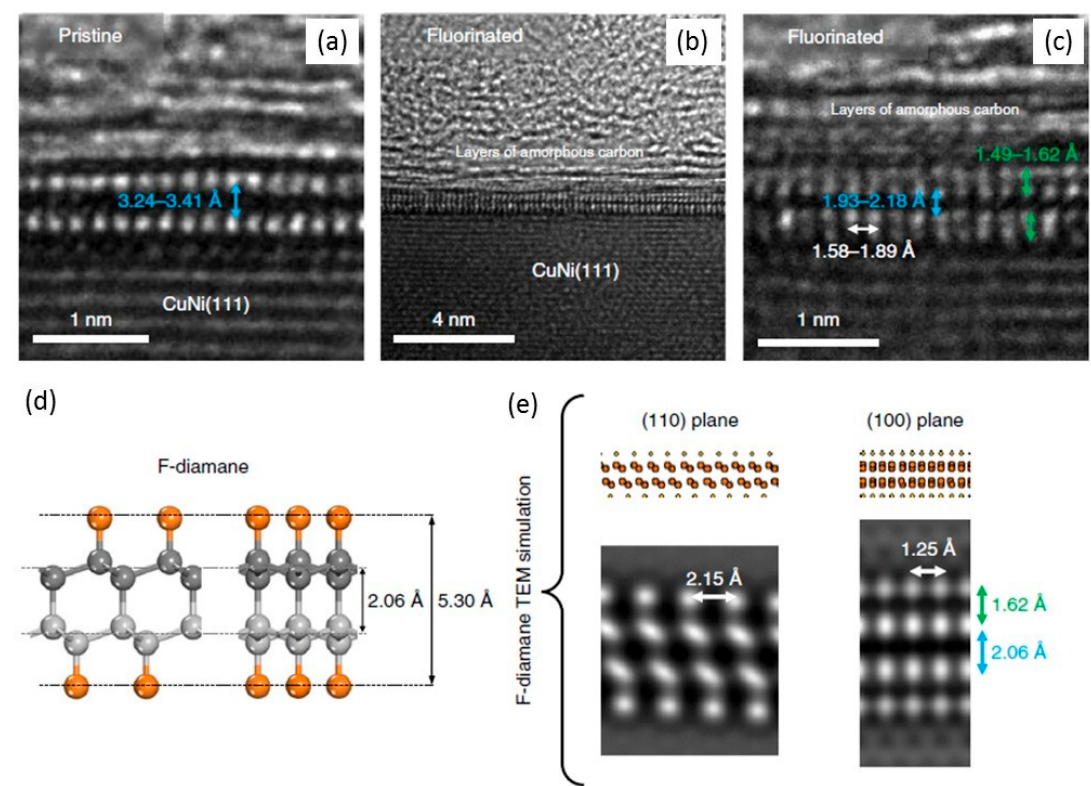
Figure 14. TEM study of F-diamane on CuNi (111) surface. High-resolution cross-sectional transmission electron micrographs of as-grown pristine graphene bilayer ( a ) and Sample A ( b , c ); simulated HR-TEM images of DFT-optimized F-diamane ( d , e ) [40].